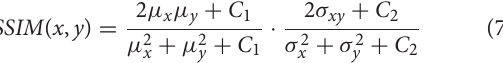
two data. When the data is transferred in the network, the